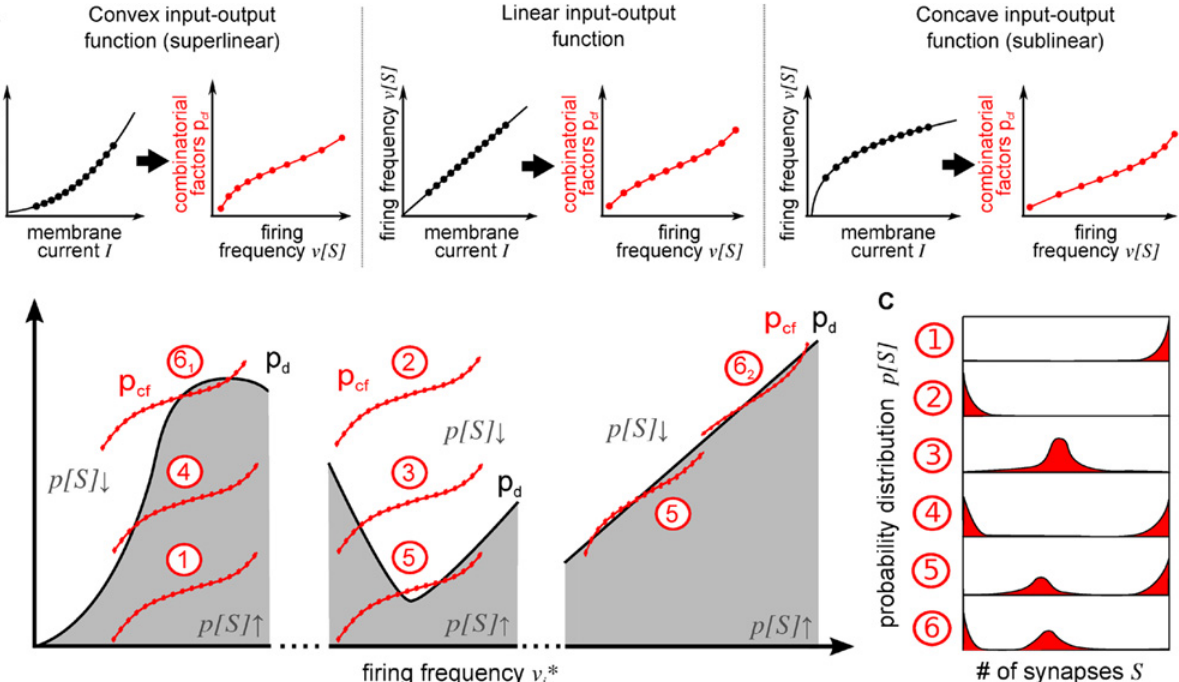
Figure 2. Possible distributions of the number of synapses of a single connection resulting from the interaction of synaptic and structural plasticity with different neuron models. (A) Three different curvatures of input-output functions F of the neuron (black) lead to different shapes (curvatures) of the combinatorial term p cf (red, see Eq. 4). For fixed presynaptic activity and postsynaptic stimulation, the lines are calculated for continuous values of S , whereas the dots mark successive discrete values. (B) When the combinatorial influences p cf (red, Eq. 4) are smaller than the logarithmic deletion probability p d (black) for a certain value of S (grey shaded area), the long-term equilibrium probability for S synapses is higher than the probability for S − 1 synapses (see Eq. 2) and vice versa. Thus, intersections of both terms indicate peaks and valleys of the probability distribution p [ S ]. To cover all six possible intersection structures between p cf and p d , we show example snippets for the p d with a variety of curvatures and slopes. (C) The shape of the long-term equilibrium probability distributions (schematically) for the number of synapses of the plastic connection can be derived from the intersection structures in (B) : each intersection in (B) leads to a local extremum in the probability distribution in (C) . Furthermore there can be peaks at the boundaries. Note, experimental connectivity (Fig. 1A) corresponds to case six which has two intersections. As p cf is monotonically growing, two intersections are only possible for growing p d